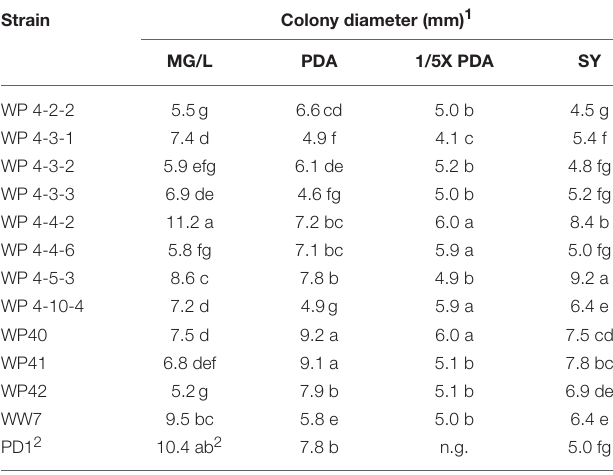
TABLE 2 | Growth of endophytes on four agar media.